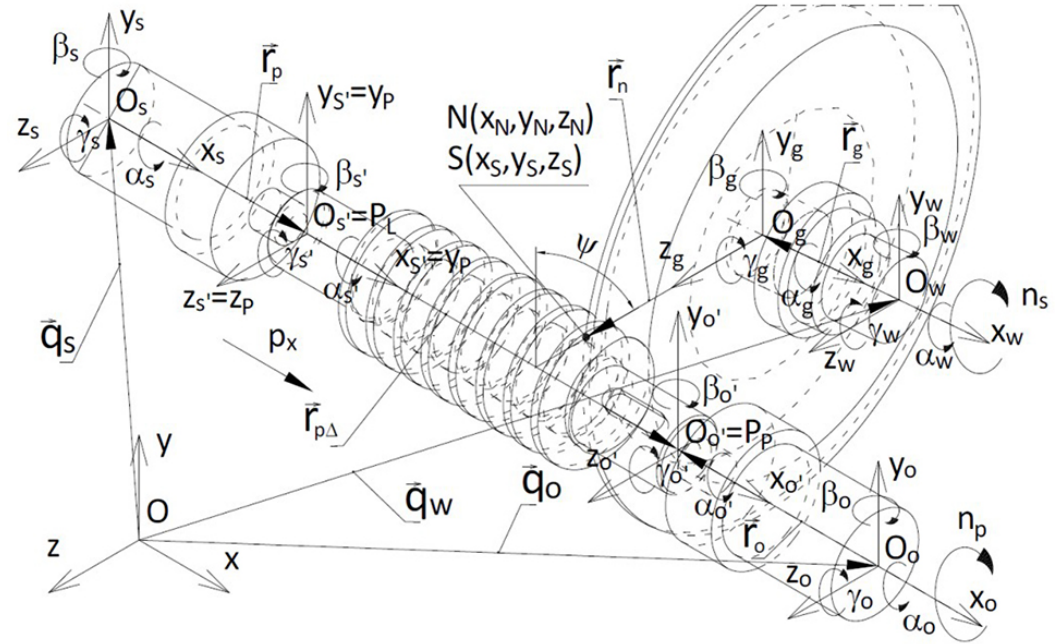
Figure 8. Shaping of the conical helical surface of the worm—kinematic system, coordinate systems of components for setting the machine tool, worm, grinding wheel, as well as vectors describing positions of components of the technological system.